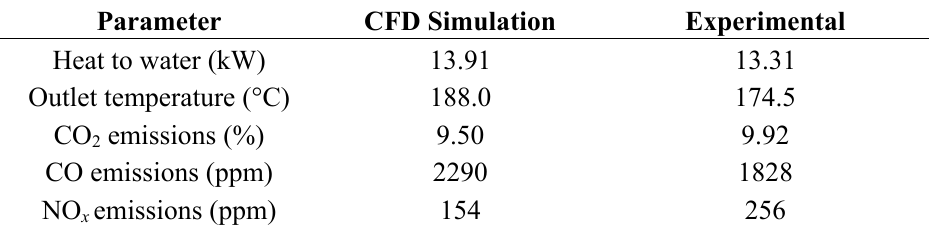
Table 4. Comparison between simulation and experimental